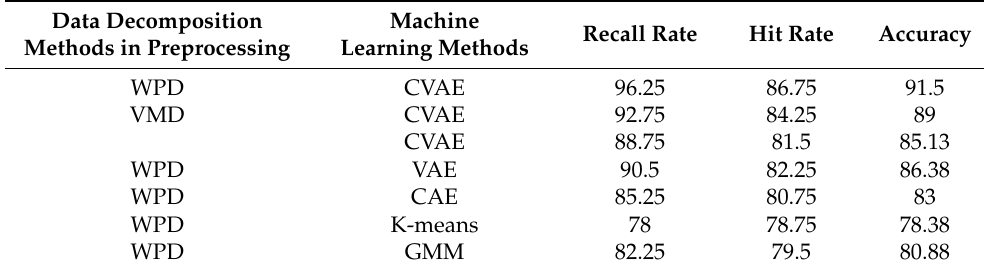
Table 6. Testing accuracy of different methods (%).